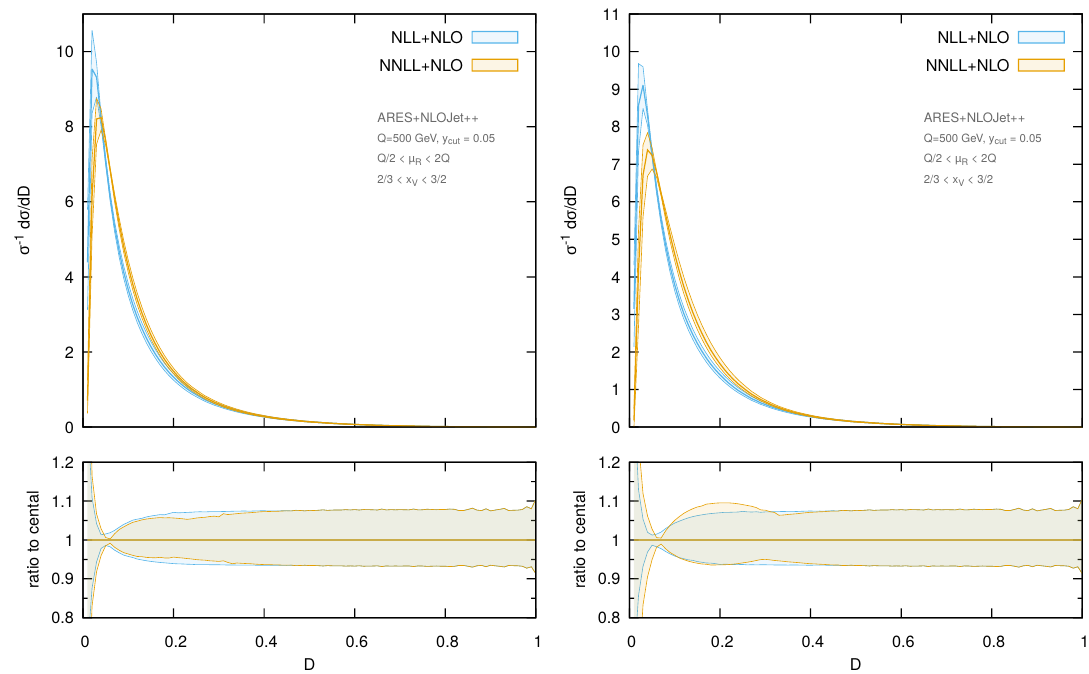
Figure 7 . The matched distribution for y cut = 0 : 05 and Q = 500GeV. The left plot using the X const scheme and the right using the X prod